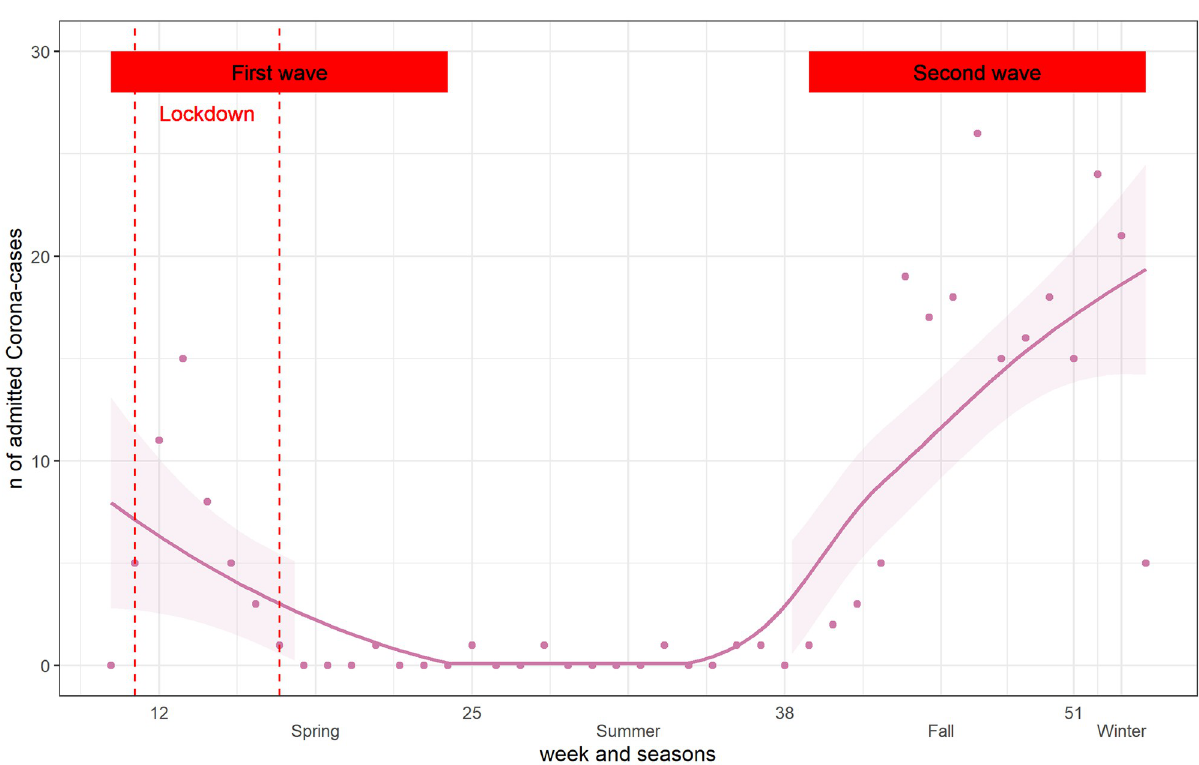
Fig 5. COVID-19 admissions by calendar week. Points represented observed values and line was the smoothed curve. 1st Wave: calendar weeks (10– 24); 2nd Wave: calendar weeks (39–53). Lockdown: March 17—April